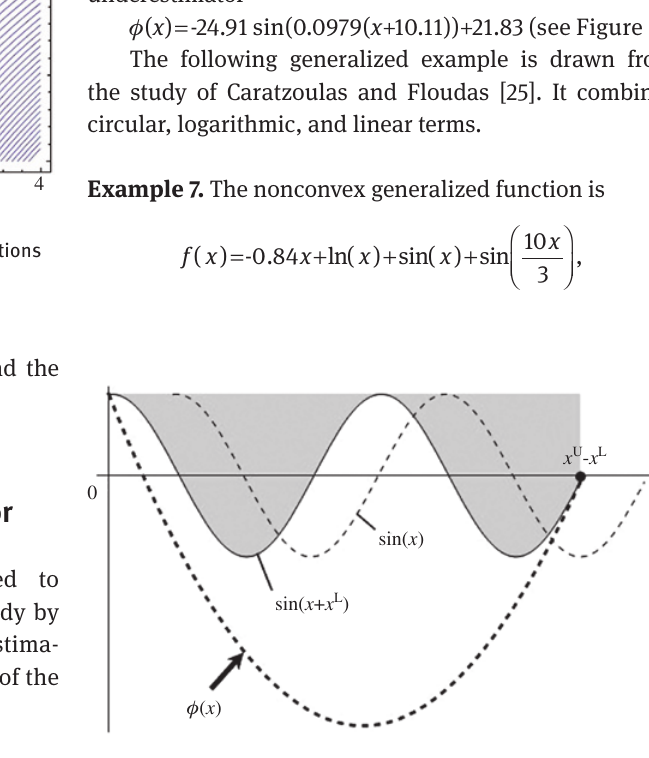
Figure 6: Convex underestimator of a sine function in Example